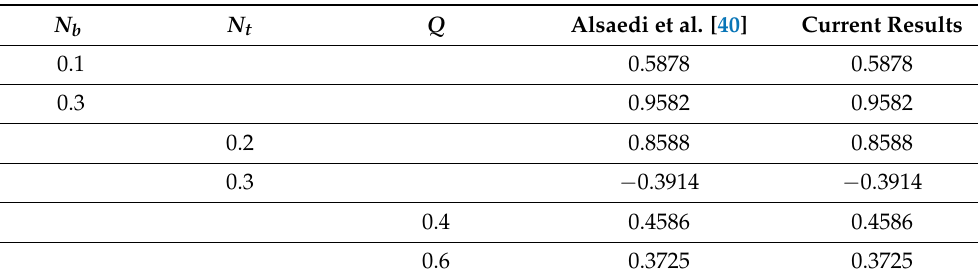
Table 3. The current approximated values of − φ (cid:48) ( 0 ) compared across the former work by granting β D = F r = 0.